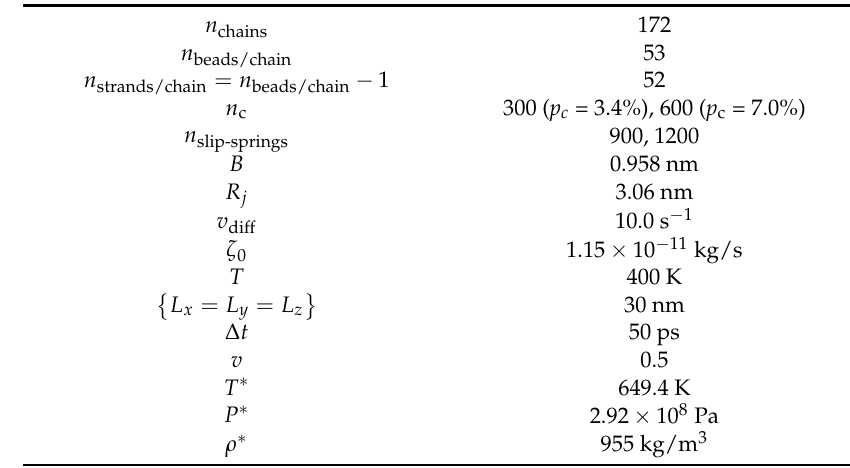
Table 1. Parameters used in Brownian dynamics/kinetic Monte Carlo (BD/kMC) simulations of crosslinked polymer